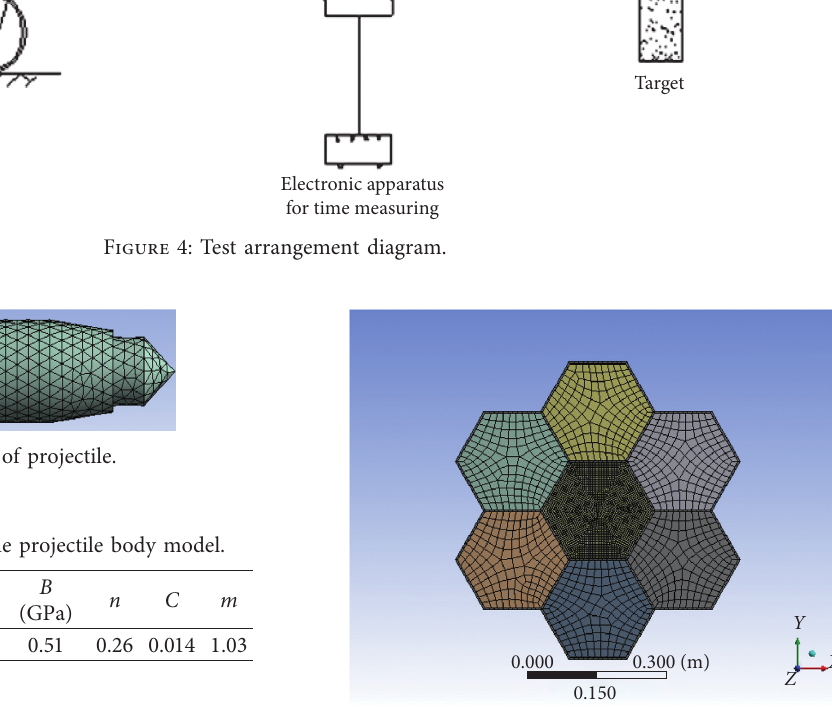
Figure 6: FEM model of HST. Table 2: The material parameters of the steel plate